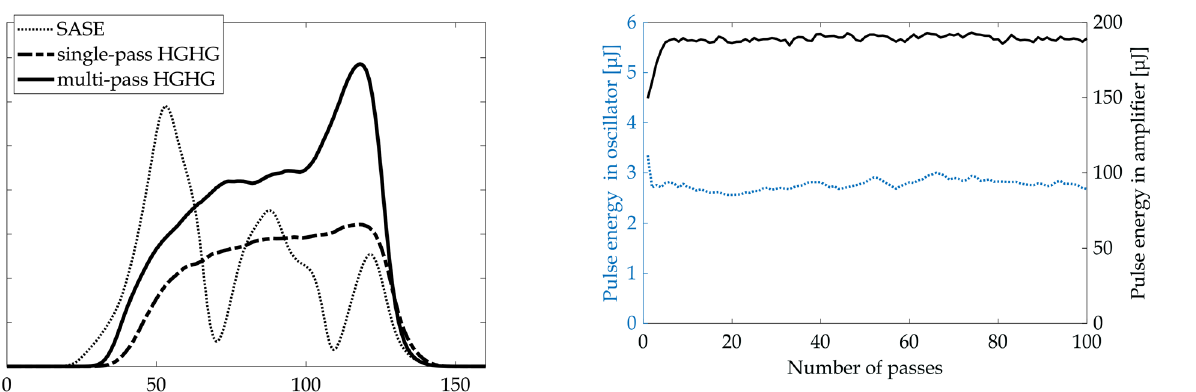
FIG. 11. Overview of the photon pulse energy per pass in the resonator (at the end of the modulator, left scale) and in the amplifier (at optimized final length, right scale). The output wavelength of the simulations is 60 nm, which is the 5th harmonic of 300 nm seed that initiates the process during the first pass only. Here we show the energy for 100 passes.